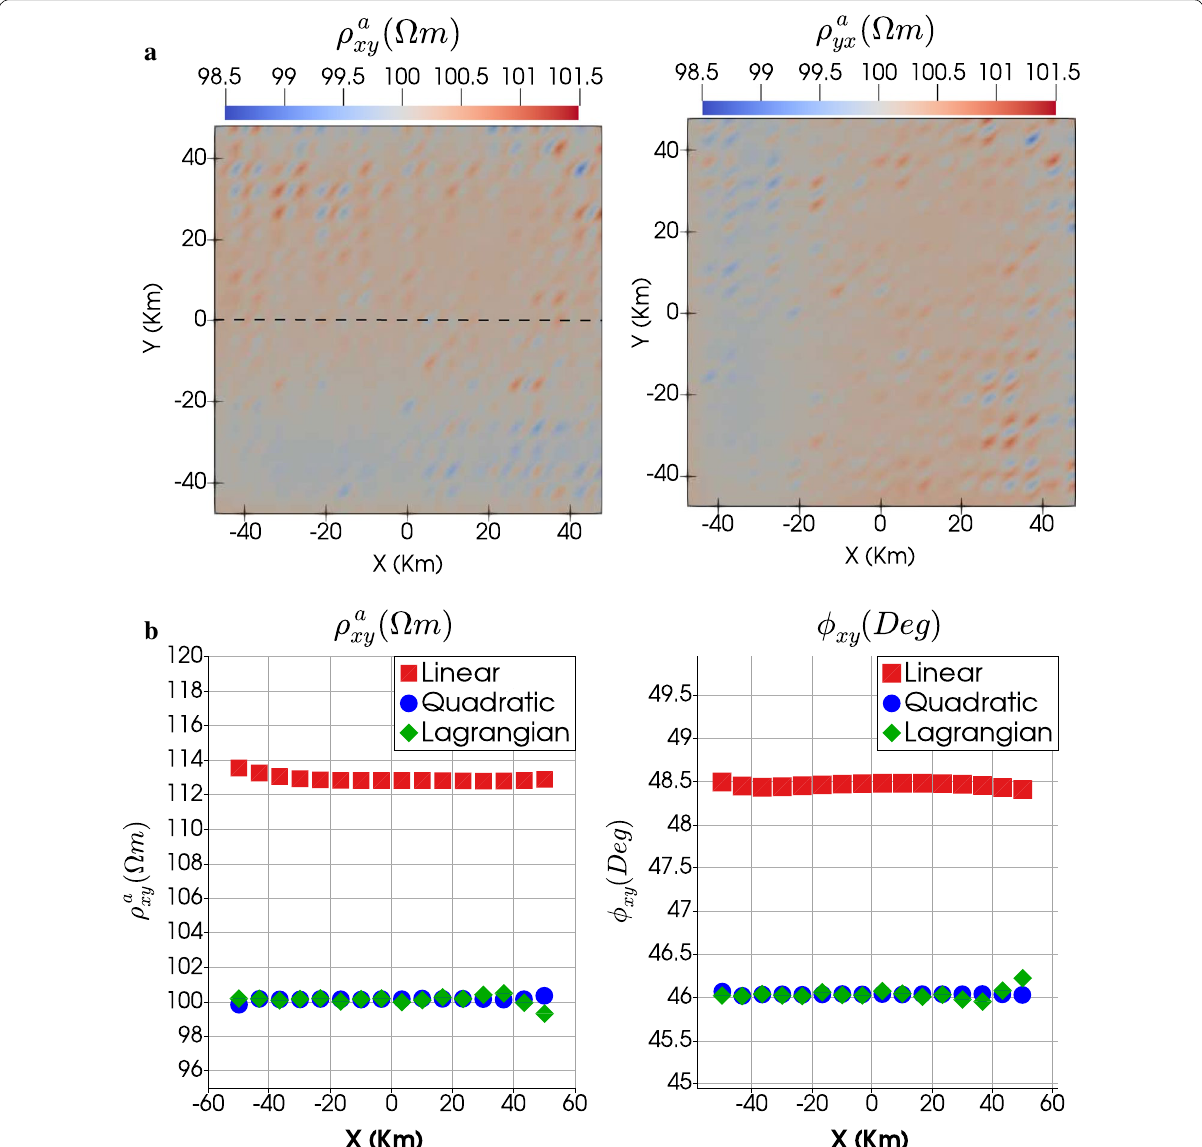
Fig. 4 MT responses obtained from applying GPML‑I boundary conditions (Fang and Wu 1996). a Apparent resistivity at the model surface for xy ‑(left panel) and yx ‑(right panel) polarizations using Lagrangian elements. b Numerical values for apparent resistivity (left panel) and phase angle (right panel) along the profile y ≡ 0 for the xy ‑polarization, shown for all implemented numerical